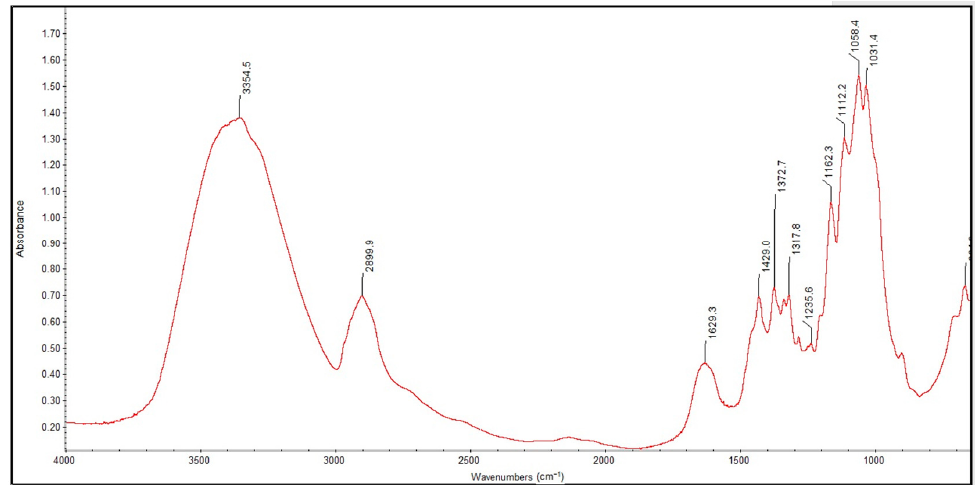
Figure 8. FTIR spectra of the impregnated gauze before irradiation sterilization.